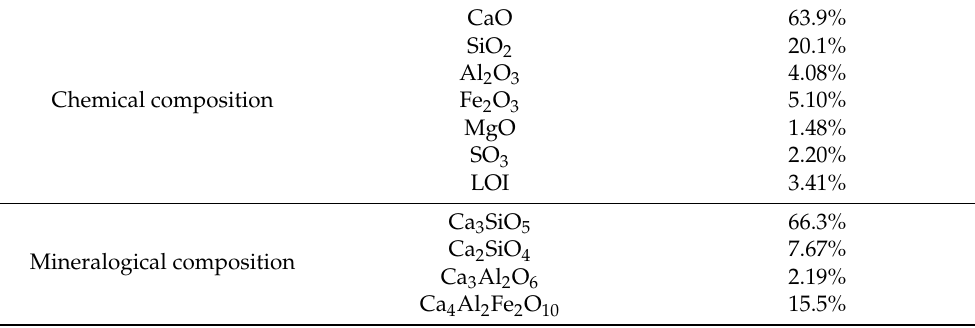
Table 1. Composition of the ordinary portland cement.